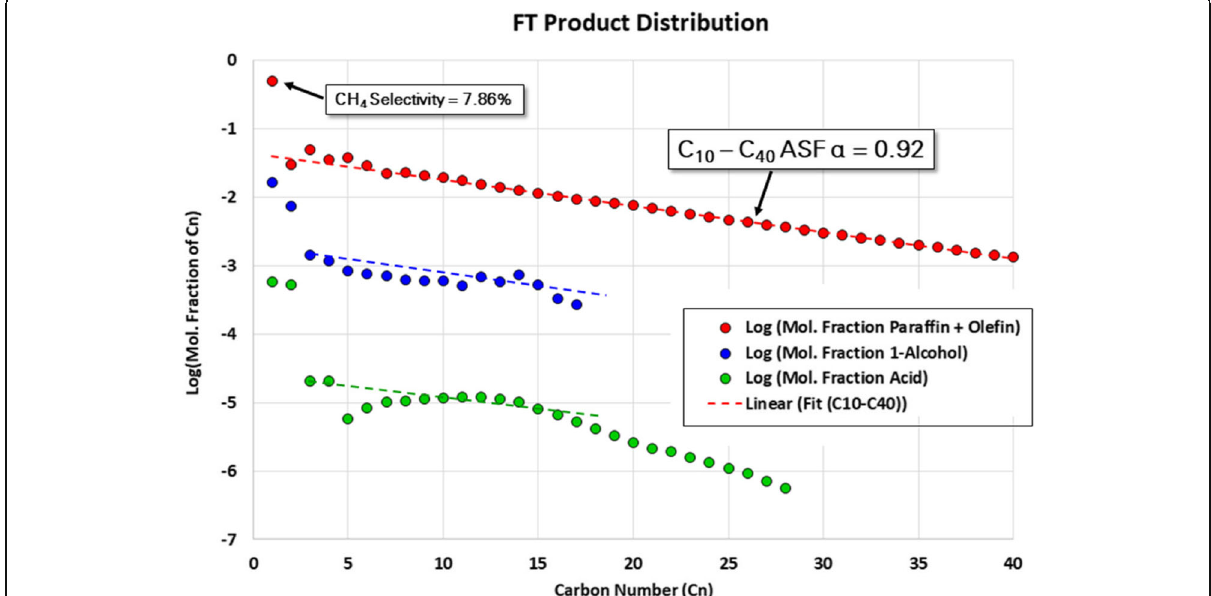
Fig. 8 Anderson-Schultz-Flory distribution for hydrocarbons, 1-alcohols and carboxylic